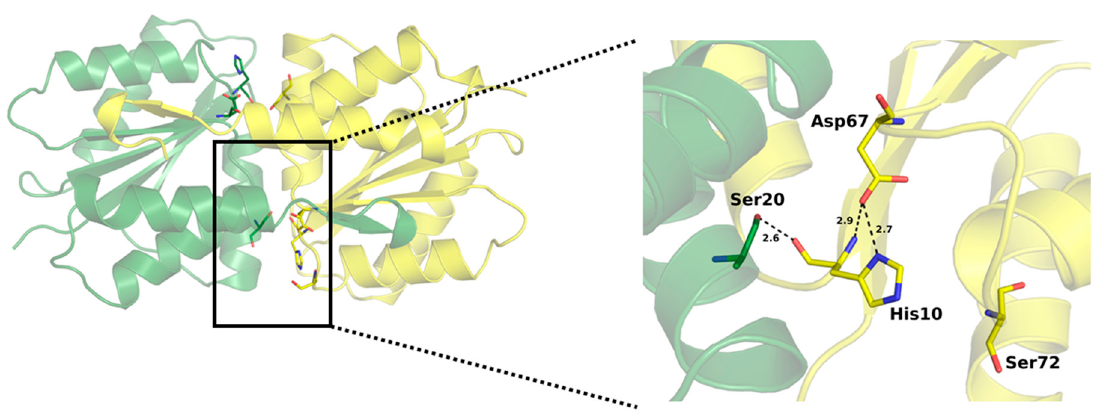
Figure 7. Active site SpEIIA-Man . Catalytic residues are shown in stick representation: His10, Asp67, Ser72 (see text for the description of the catalytic process).